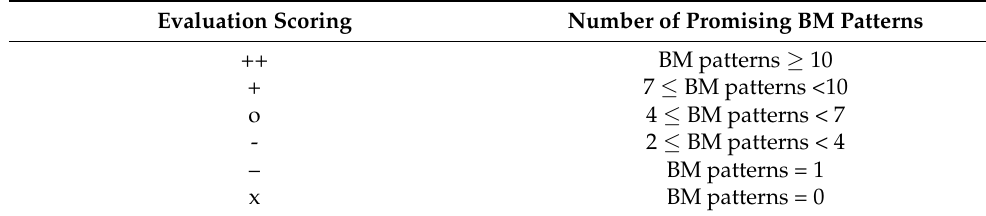
Table A6. Conversion table used for the number of promising BM